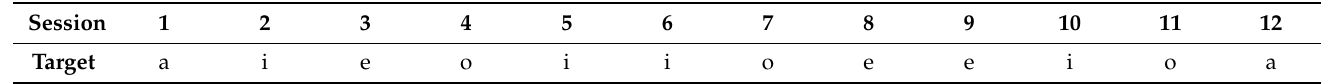
Table 3. Target of the auditory ERP components using stimuli as vowel sounds with a duration of 100 and 250 ms.